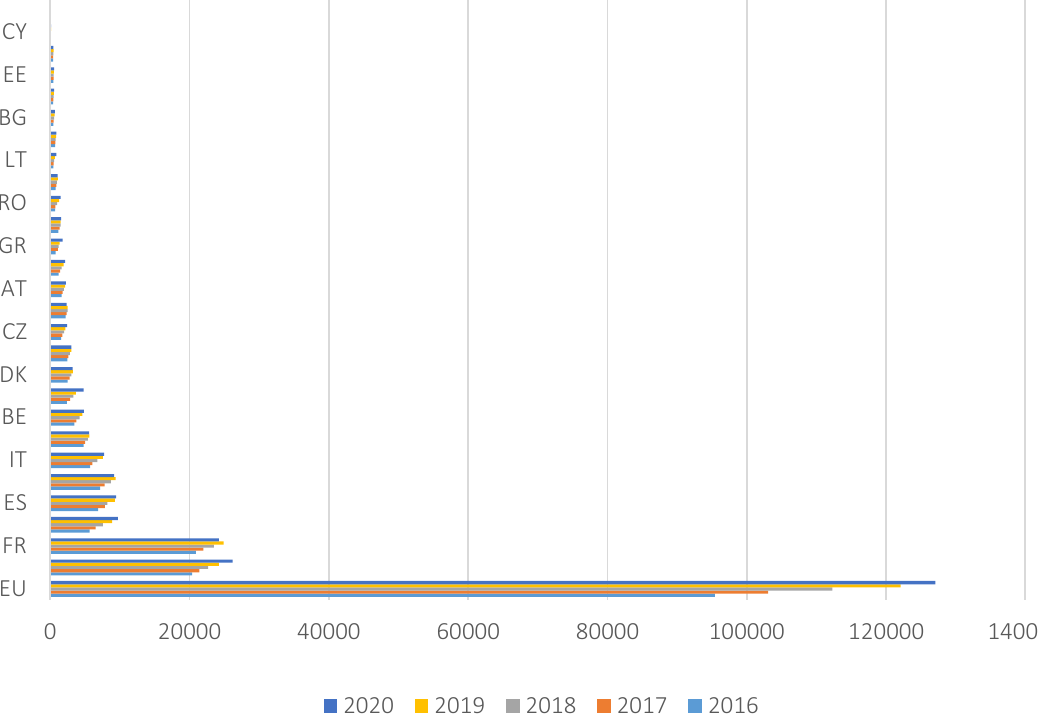
Figure 7. The dynamics of the number of non-cash payments in the EU in 2016–2020, mln pcs.